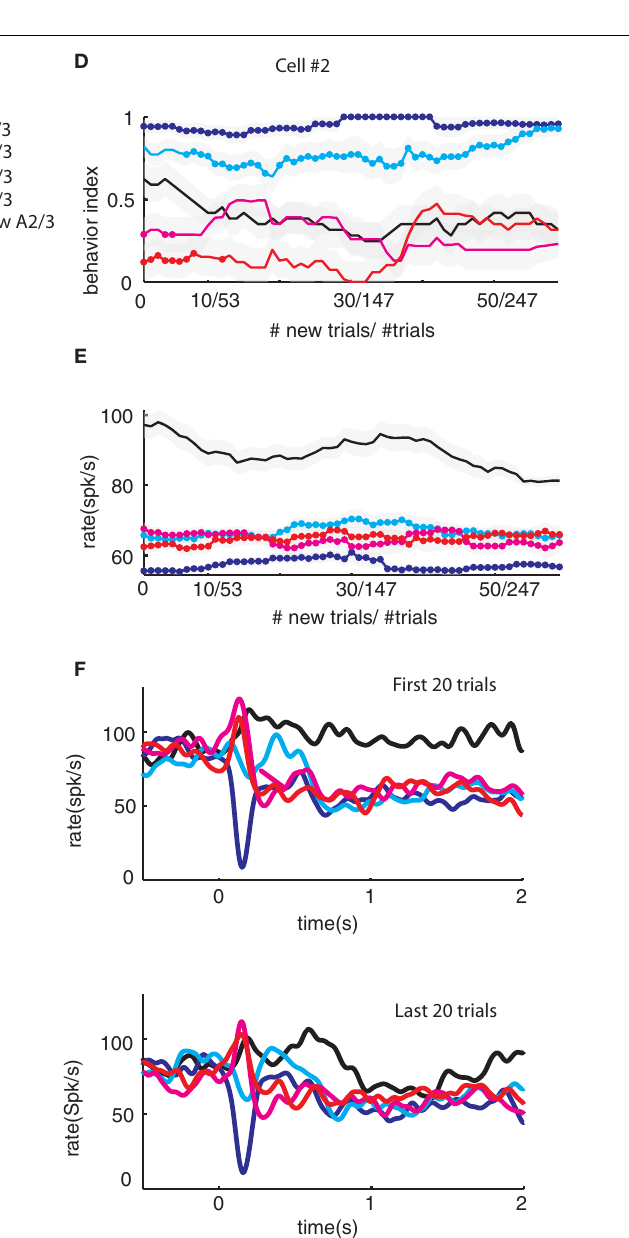
FIGURE 2 | Examples of the activity of two SNpr neurons during presentation of new and familiar cues. (A) The behavior-index during the learning of a new aversive cue as a function of the new and total (new + familiar) number of trials in a single behavioral session. The new cue predicted the aversive outcome with a probability of 2/3. Responses were smoothed by a moving average of 20 new trials (black line) or a moving average of 20 corresponding familiar trials (blue and red lines for the rewarding and aversive events, respectively). Dots on the blue and red lines mark times in which the responses to the new cue were signifi cantly different from the response to the familiar cue ( t -test, p < 0.05). (B) Response of a SNpr neuron to familiar and new cues. Spike rate ( ± SEM shaded) as a function of the new and total number of